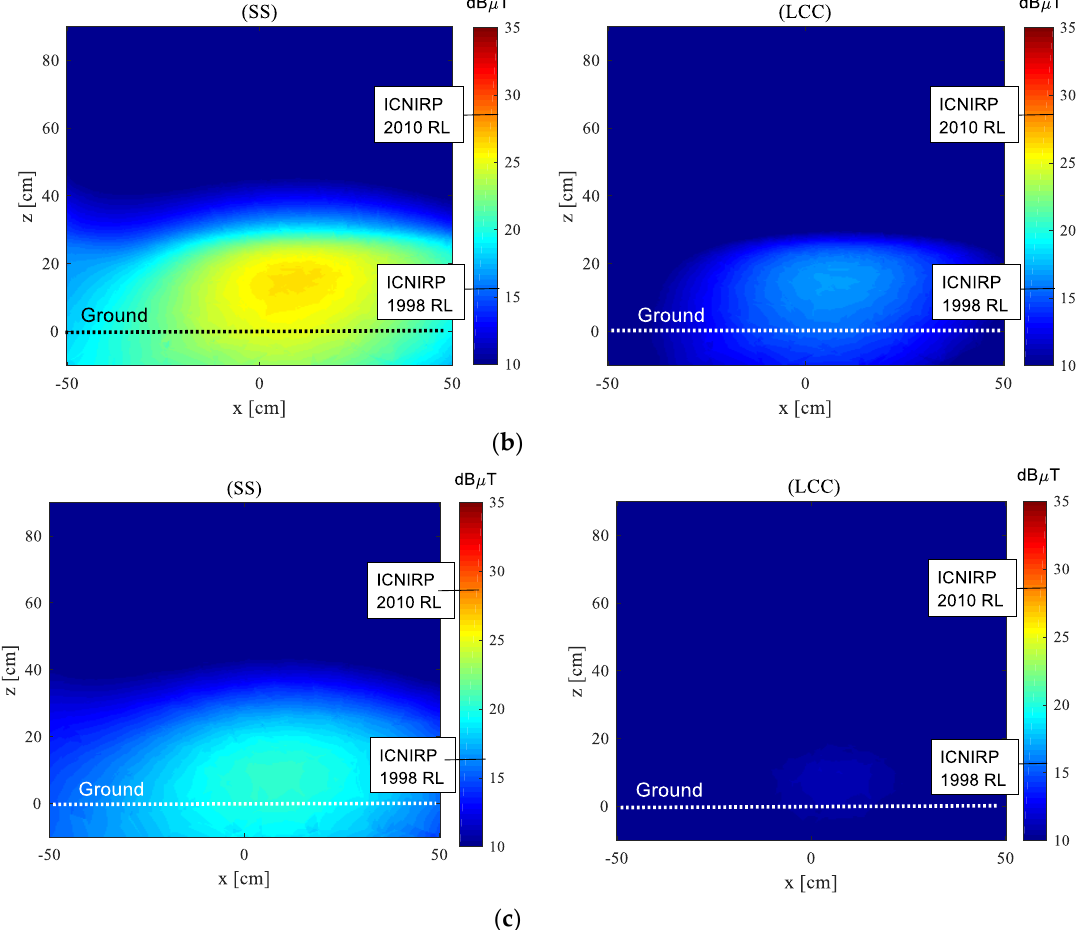
Figure 22. Maps of the magnetic flux density B (rms) on the plane p 1 for d y = 0.45 m ( a ), d y = 0.50 m ( b ), and d y = 0.55m ( c ) for SS and LCC compensations.